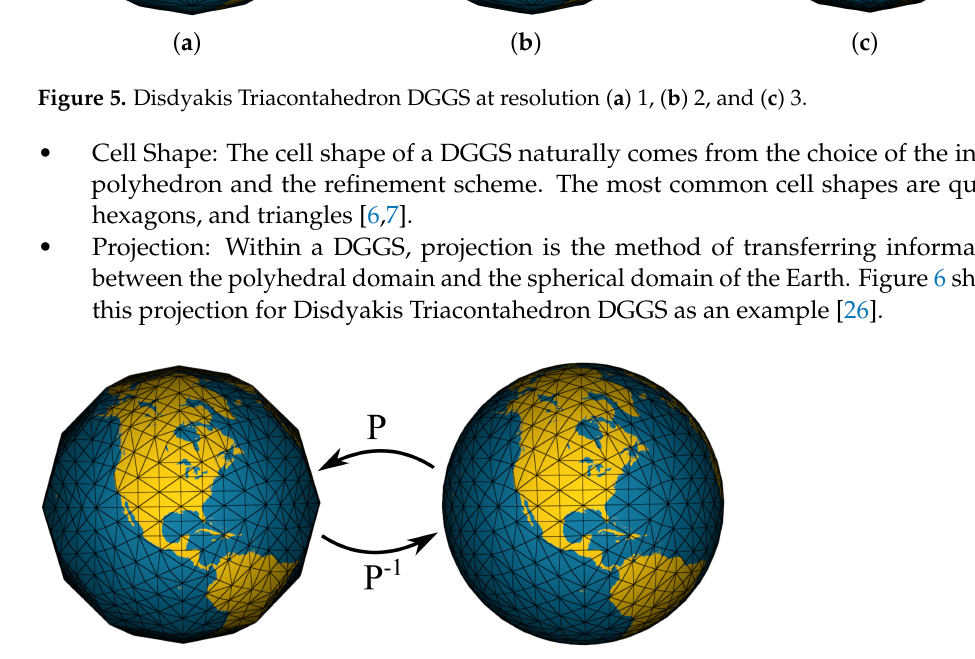
Figure 6. Disdyakis Triacontahedron DGGS at resolution three in the polyhedral domain ( left ) and the spherical domain ( right